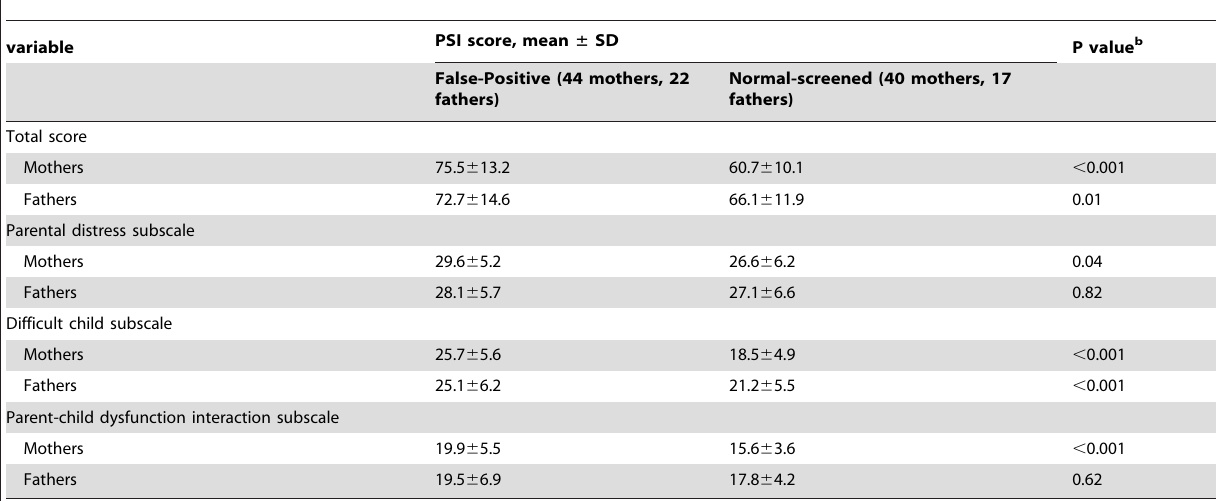
Table 2. Impact on the family: PSI scores for False-Positive and Normal-screened group. a